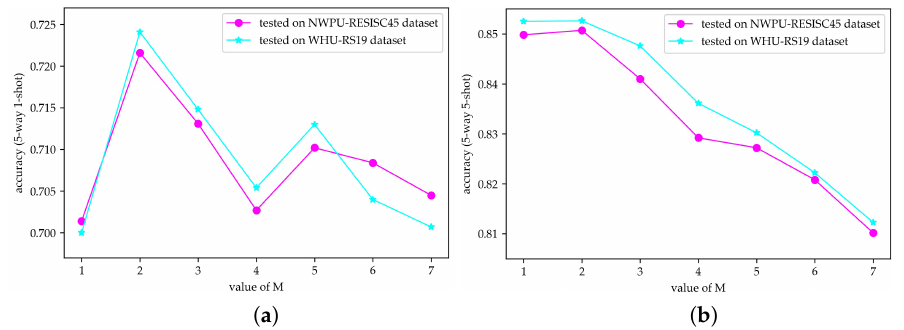
Figure 7. Accuracies with different number of selected prototypes, where M denotes the number of selected prototypes. ( a ) shows the results of 5-way 1-shot case, and ( b ) shows the results of 5-way 5-shot